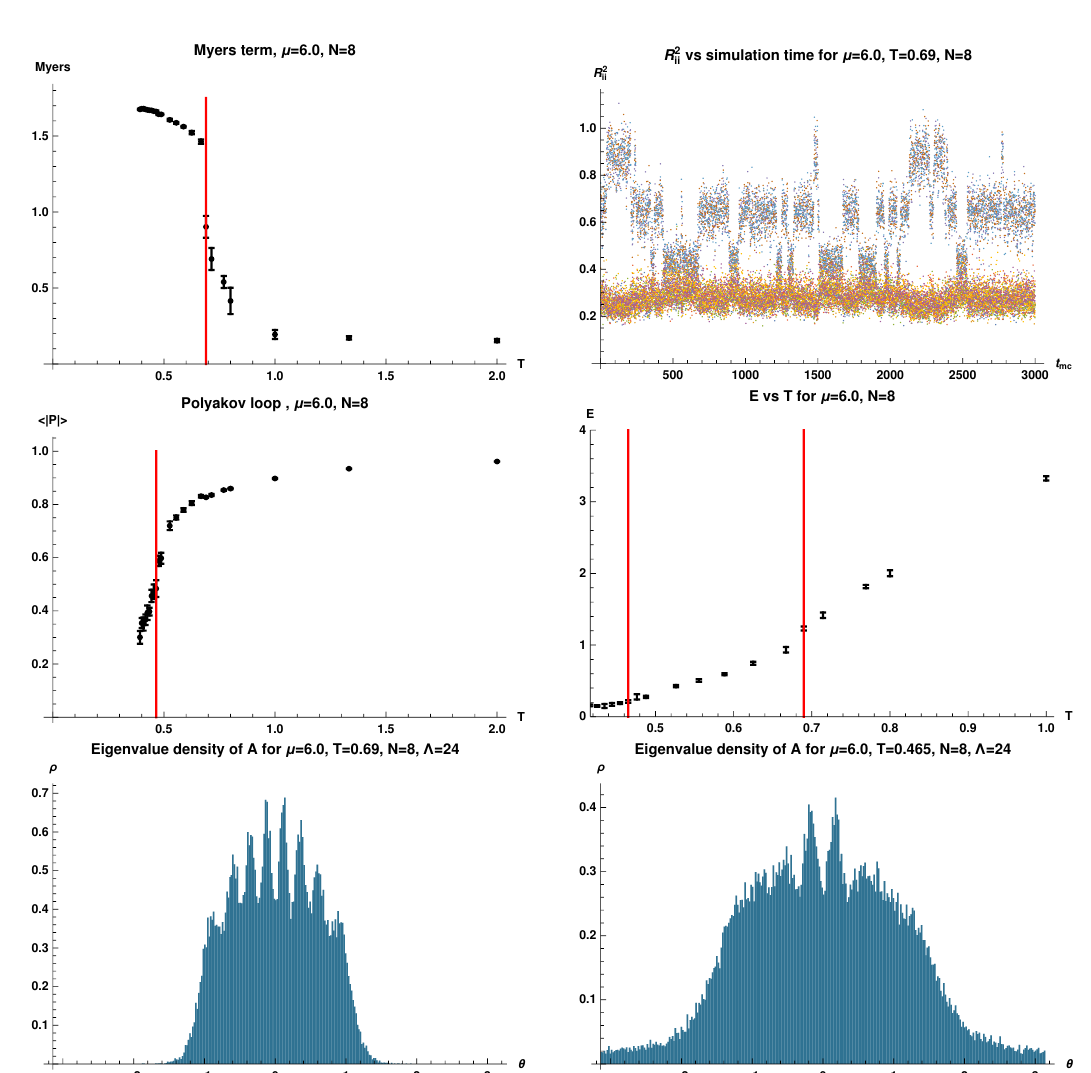
Figure 2 . The (cid:12)gure shows the Myers observable, the Polyakov loop and the energy for (cid:22) = 6 : 0 and N = 8. Two transitions occur at distinct temperatures, with the Myers transition occurring at T c 1 = 0 : 690, while the Polyakov transition, visible in both the Polyakov loop and eigenvalue density of the holonomy, occurs at T c 2 = 0 : 465. The top right (cid:12)gure shows R 2 for each of the nine ii matrices at T c 1 = 0 : 690 marked as the red vertical line in the Myers plot and the higher temperature line in the energy plot. The upper points correspond to the SO(3) matrices. The Polyakov loop shows a transition at T c 2 = 0 : 465, which is marked as the second lower temperature red line in the energy plot. The corresponding eigenvalue distributions for the holonomy at both transition temperatures are plotted, and one can see that Polyakov loop transition involves the eigenvalue distribution changing from gapped to ungapped.